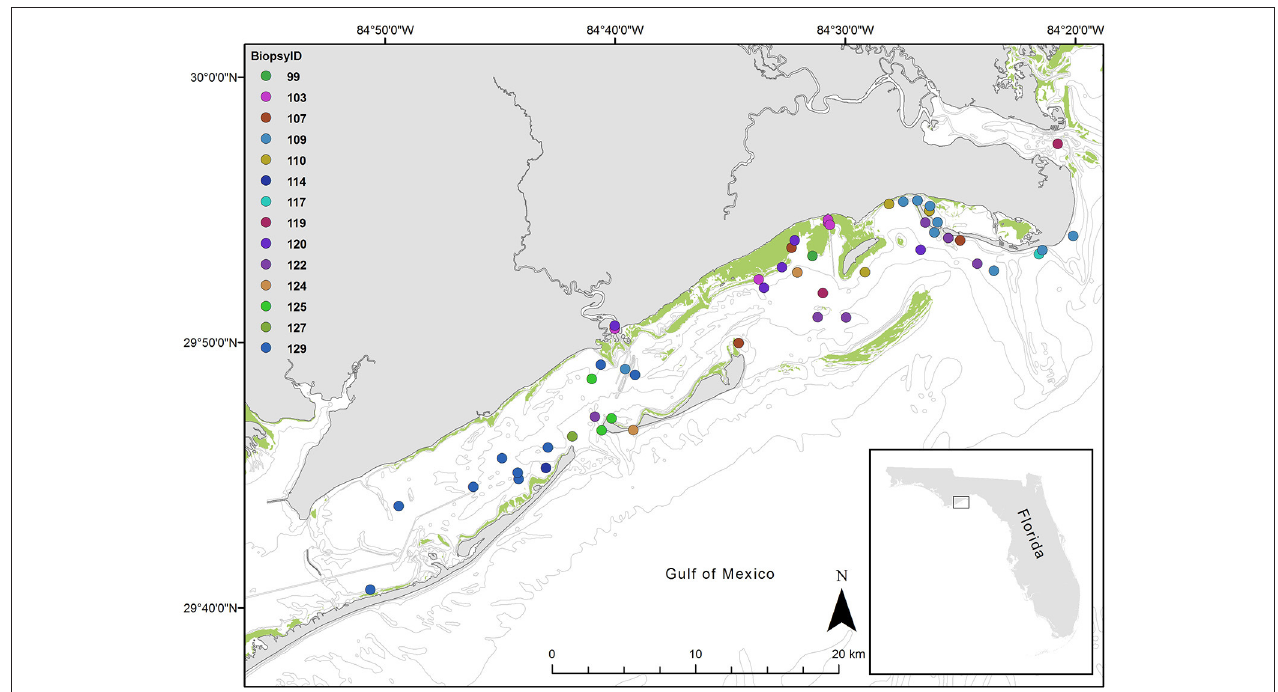
FIGURE 1 | Map of study area, St. George Sound, Gulf of Mexico. Points represent each sighting location for dolphins sighted over the study period. Colors indicate dolphin ID as indicated in the legend. The inset map shows St. George Sound in the context of the state of Florida, USA. The green shading indicates known seagrass